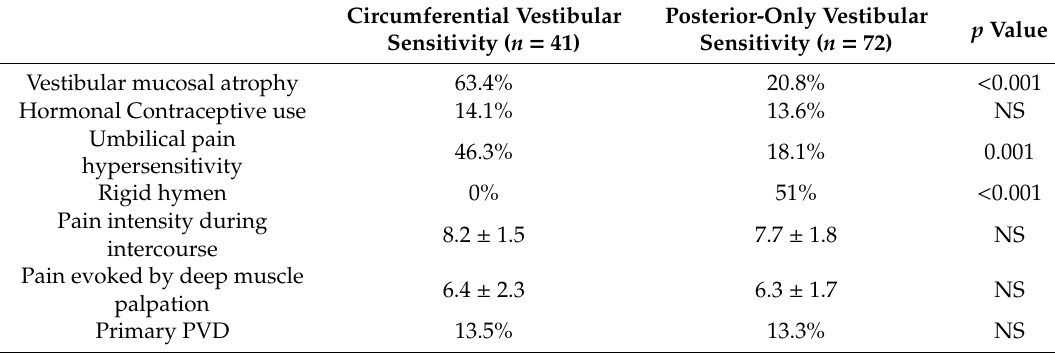
Table 2. Comparison of Circumferential vs. Posterior-only vestibular tenderness